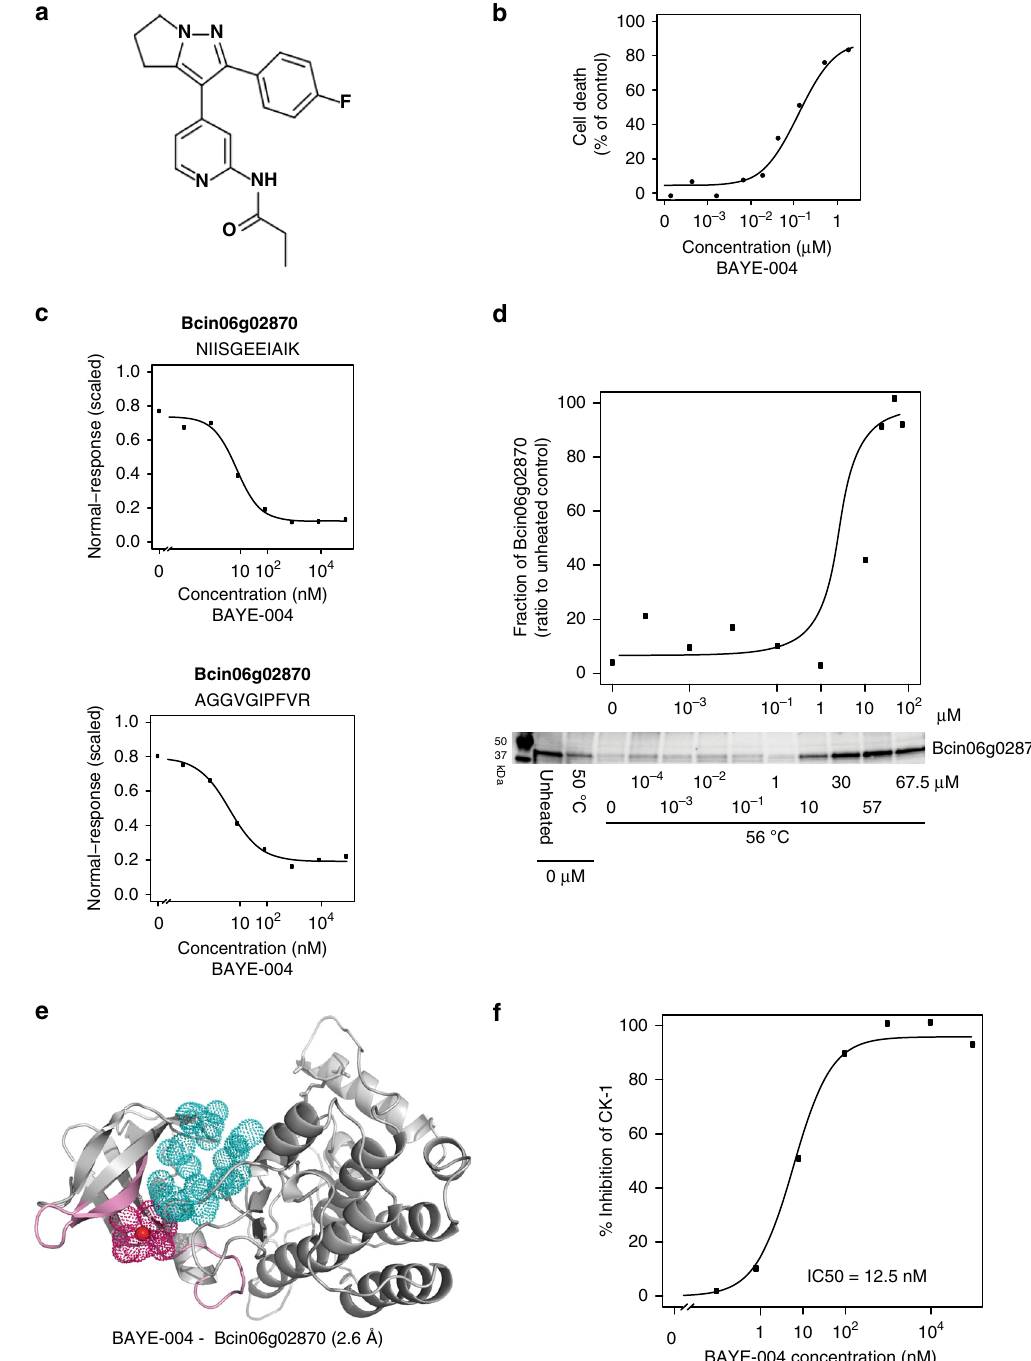
Fig. 4 Identi fi cation of the kinase target and its binding site of a fungicide. a Chemical structure of the novel compound BAYE-004. b Inhibition of growth in Botrytis cinerea cells upon treatment with increasing concentrations of BAYE-004. c Dose – response curves showing relative intensities of the top two LiP-Quant peptides from Bcin06g02870, based on LiP-Quant score in the presence of increasing concentrations of BAYE-004. Bcin06g02870 is a serine/threonine kinase predicted to be casein kinase I. The extrapolated average EC50 for this protein is 6 nM. d Thermal stability of His-tagged Bcin06g02870 upon treatment with increasing concentrations of BAYE-004. Western blots and the corresponding quanti fi cation of the soluble fraction of Bcin06g02870 at 56 °C ( n = 2). e Homology model of the structure of Bcin16g04330 kinase (from template PDBID: 3gzd, see Methods section). Red dot shows the center of mass of the LiP-Quant peptides (pink) for this protein. Magenta dots represent a 4 Å radius around the center of mass. It is positioned within the volume of the catalytic site (cyan), which is a common binding site of other kinase inhibitors. The volume of the catalytic site was calculated based on a model of a protein bound to a kinase inhibitor (PDBID: 3gzd). f LANCE Ultra kinase assay of CK-1 inhibition upon incubation with increasing concentrations of BAYE-004. Source data are provided as a Source Data fi